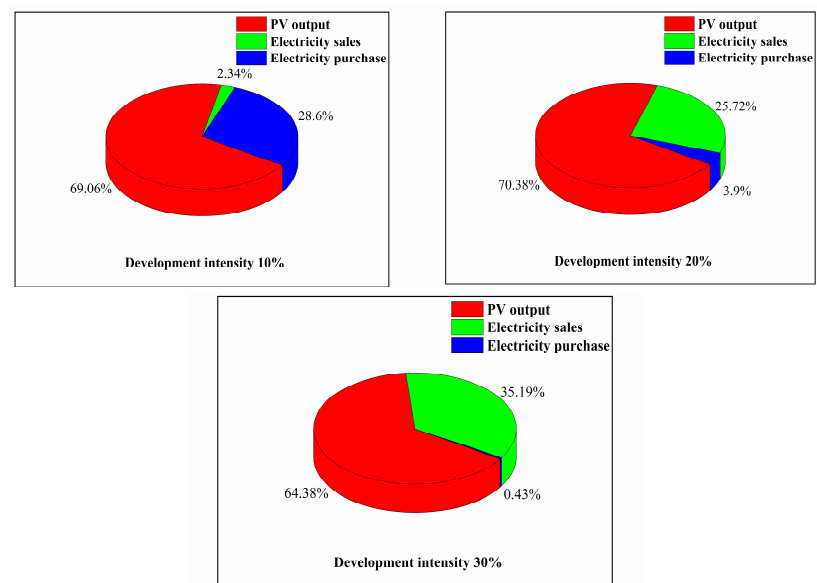
Figure 9. Comparison of PV output, electricity sales, and electricity purchase in different.